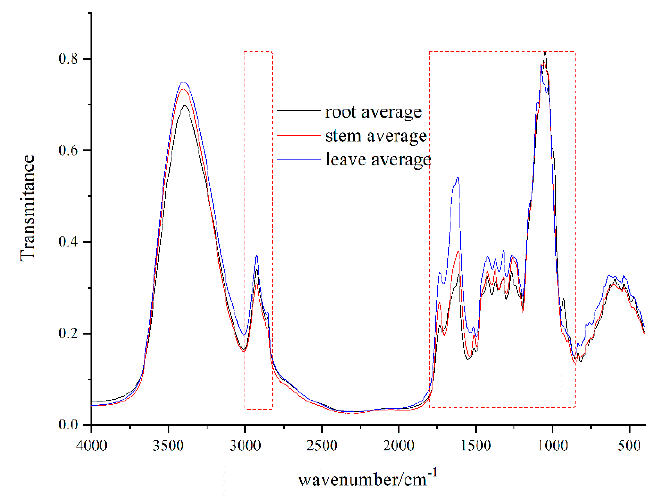
Figure 2. The average spectrum of root, stem, and leaf for G. rigescens from different geographical areas.